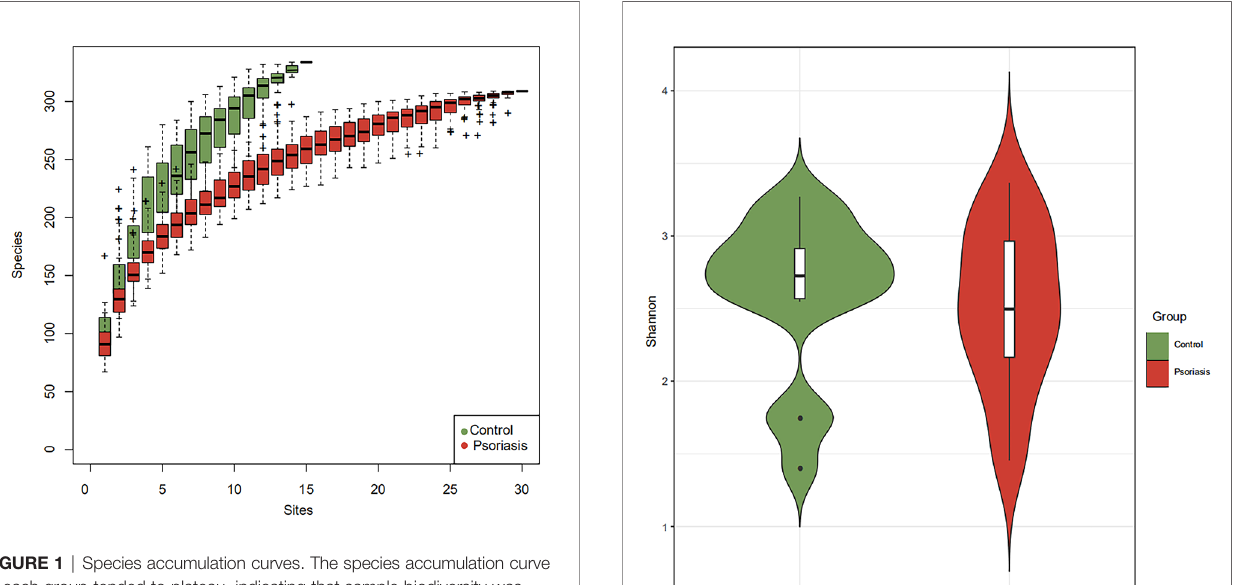
FIGURE 1 | Species accumulation curves. The species accumulation curve of each group tended to plateau, indicating that sample biodiversity was adequately covered with the applied sequencing